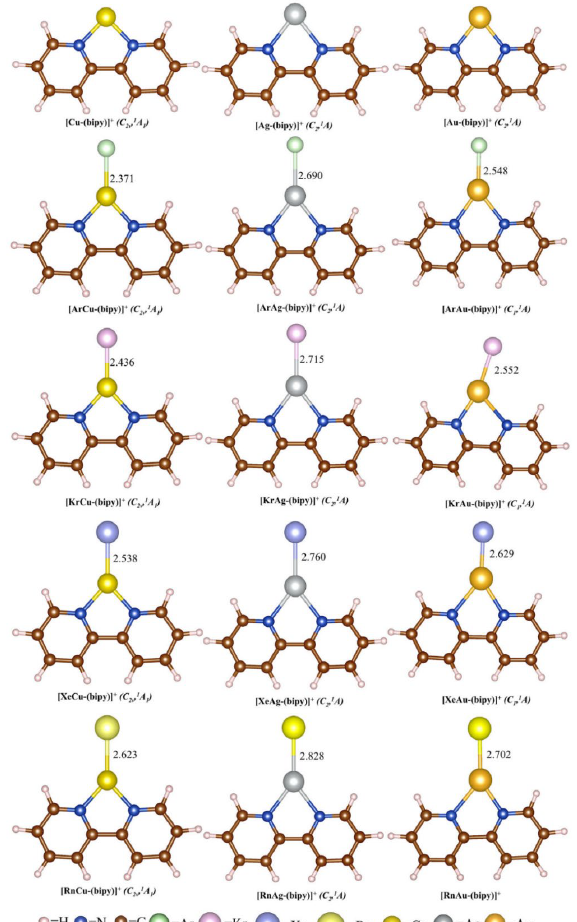
Figure 2. Optimized geometries of the monocationic M-bipyridine complexes at the MPW1B95/cc- pVTZ level of theory, along with the respective bond distances (in Å). [Reprinted from Ref. [85] with